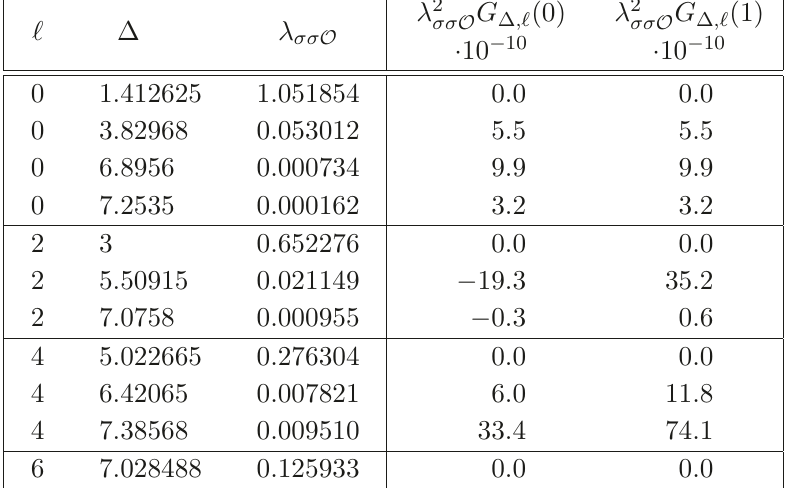
Table 1 . List of operators with dimension ∆ 8 that enter the σ σ OPE in the critical 3d Ising ≤ × model, with their spin ℓ , scaling dimension ∆, OPE coefficient λ σσ O , and the contribution of these operator to the imaginary part of the 4-point function at x = 0 and x = 1. σ is the lowest-dimension scalar operator, with ∆ σ = 0 . 5181489. The data on the left-hand side of this table is taken from ref. [59], while the right-hand side is computed from the conformal blocks.